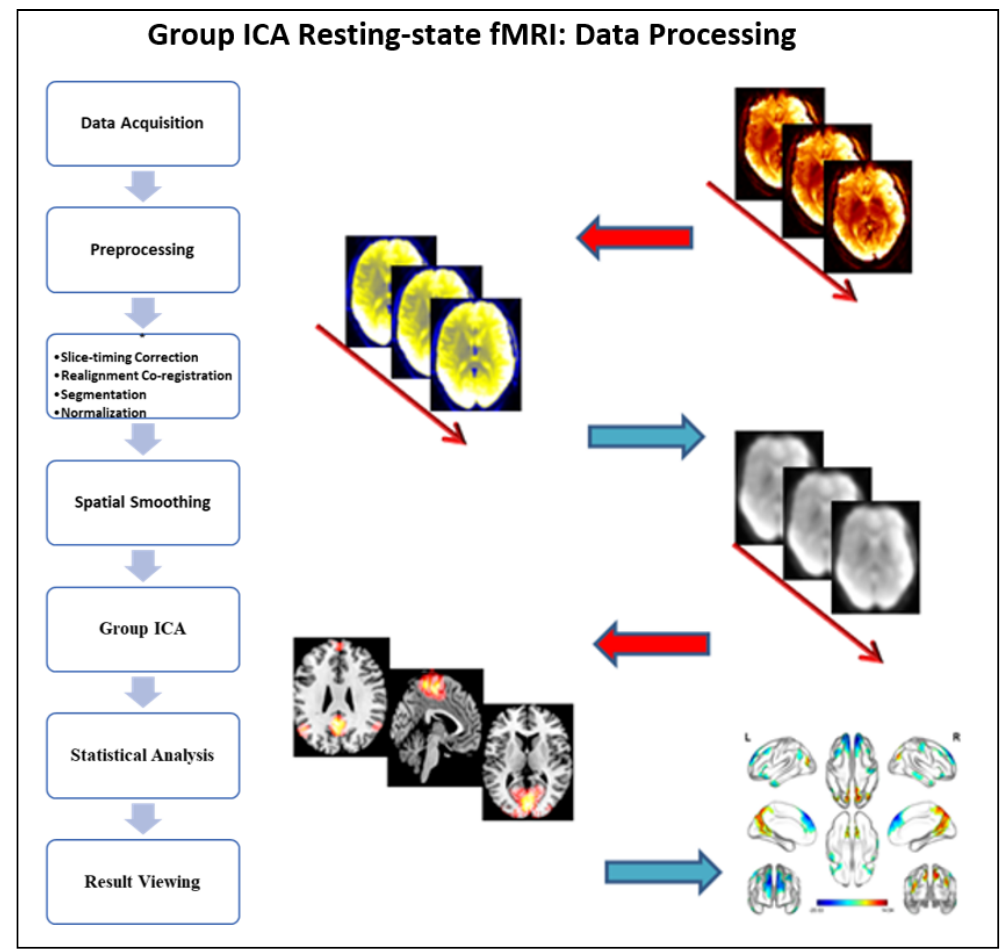
Figure 1. General flowchart of independent component analysis.